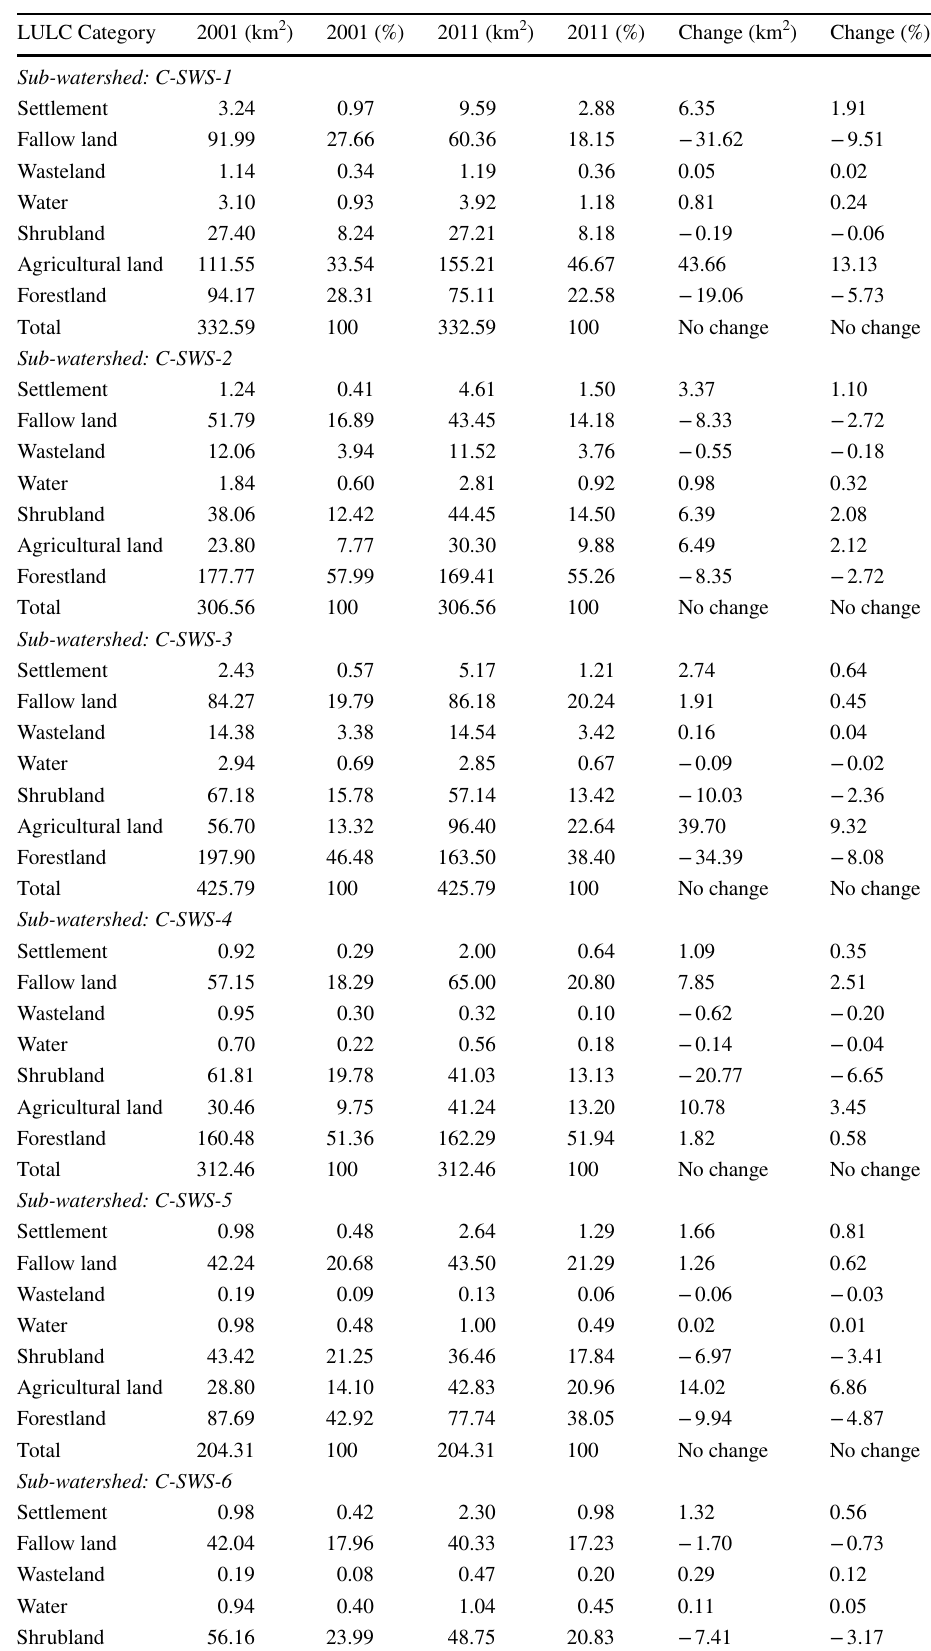
Table 7 Sub-watershedwise LULC change from the year 2001 to 2011 of the Champua